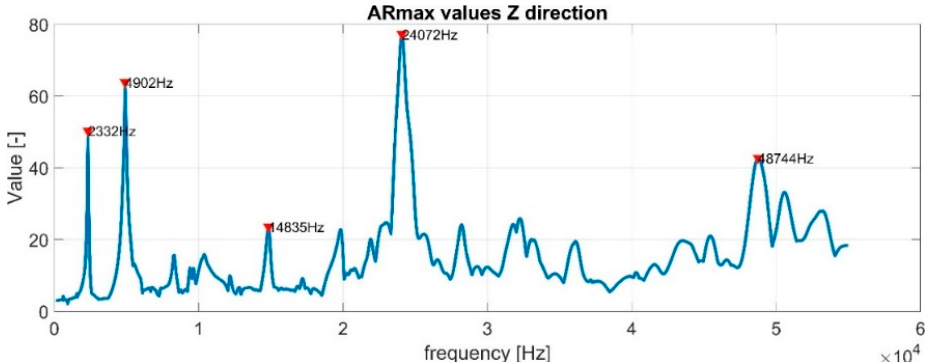
Figure 1. Example of the ARmax characteristic.